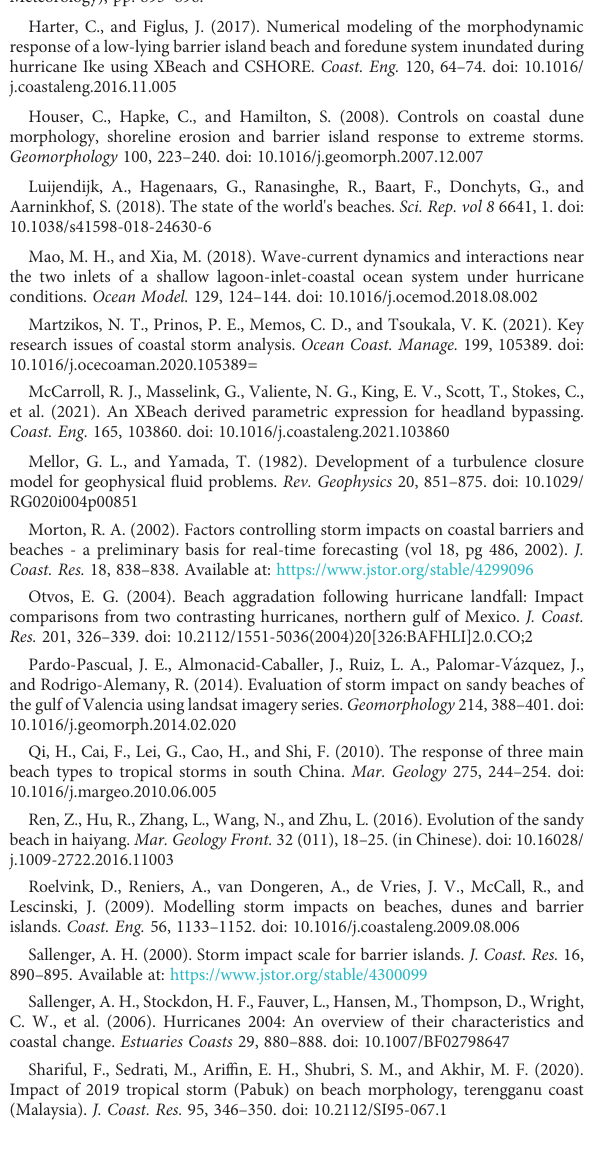
SUPPLEMENTARY FIGURE 4 TheDEMofstudy areainChinaGeodeticCoordinate System2000(CGCS 2000) and Gauss-Kruger projection, and the black line represents the P2 pro fi le. SUPPLEMENTARY FIGURE 5 The generated different wind fi elds at Haiyang Beach when the wind velocity was at its